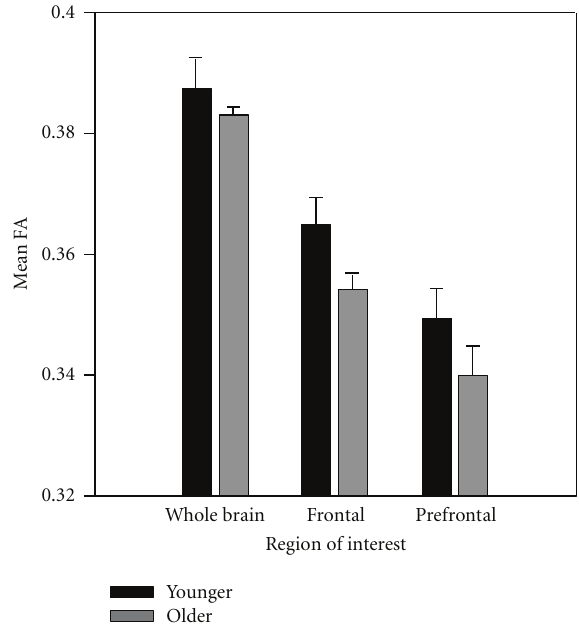
Figure 4: FA for older and younger adults for both frontal and whole brain regions of interest. Error bars represent 1 SEM.